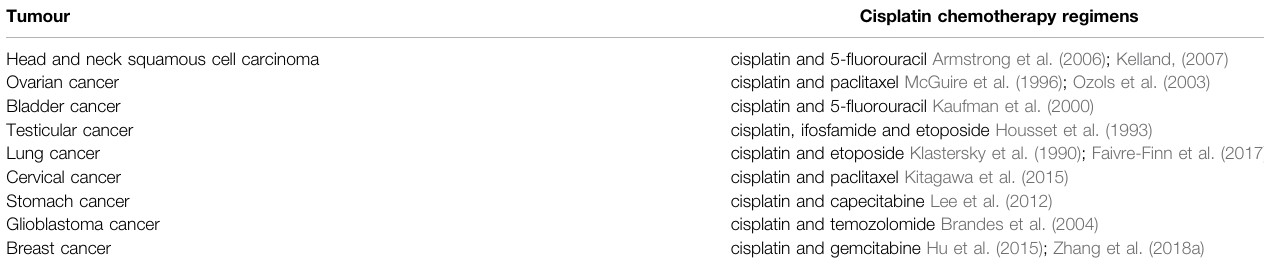
TABLE 1 | The chemotherapy regimens of cisplatin in various tumours. Tumour Cisplatin chemotherapy regimens Head and neck squamous cell